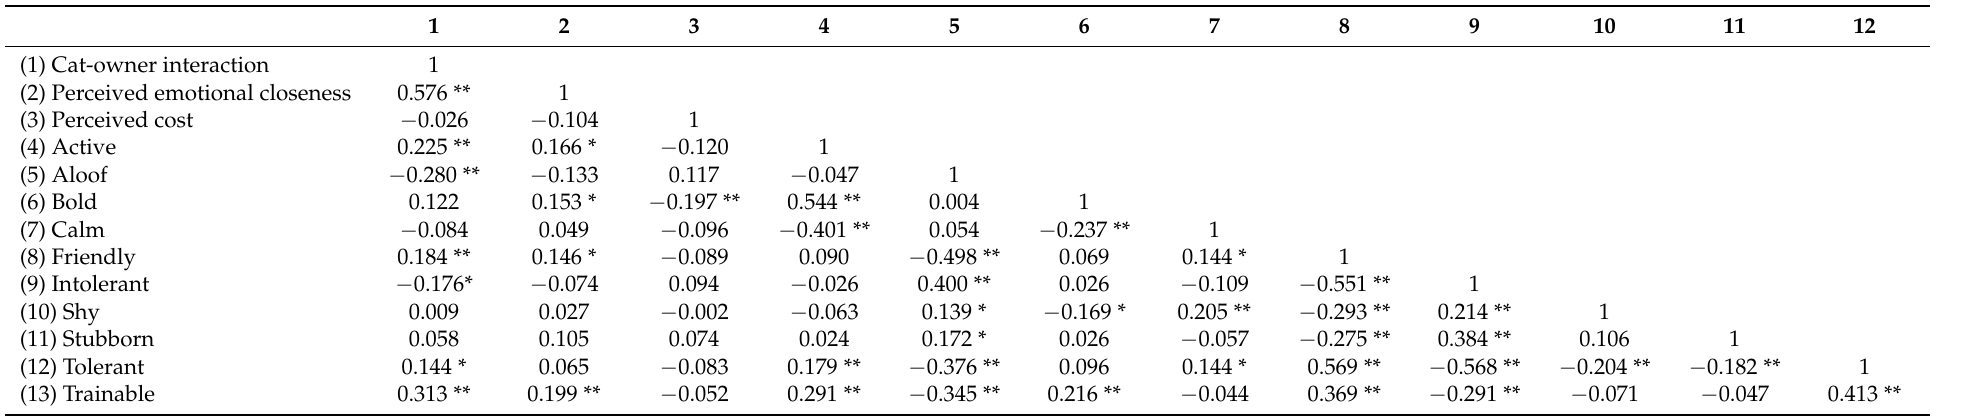
Table 4. Spearman correlations between CORS subscales and personality